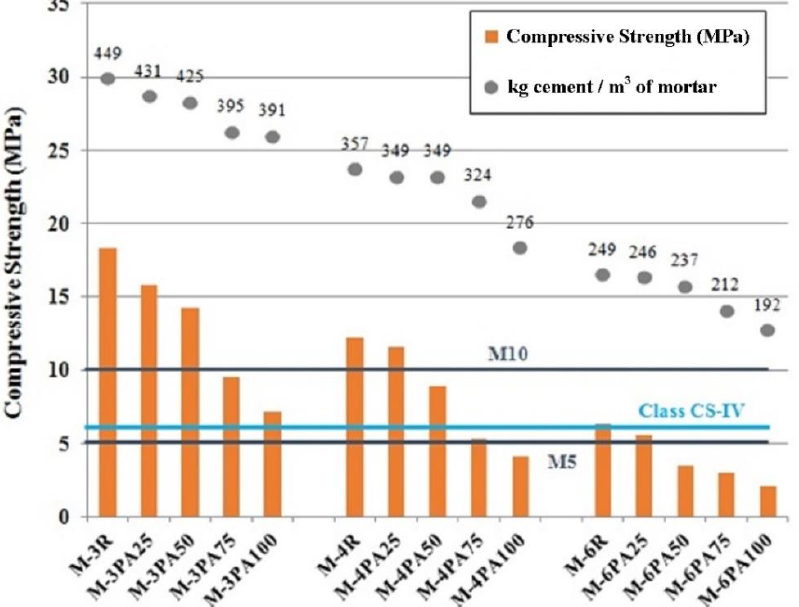
Figure 2. Comparison between the compressive strength values (MPa) and kg cement / m 3 of mortars.